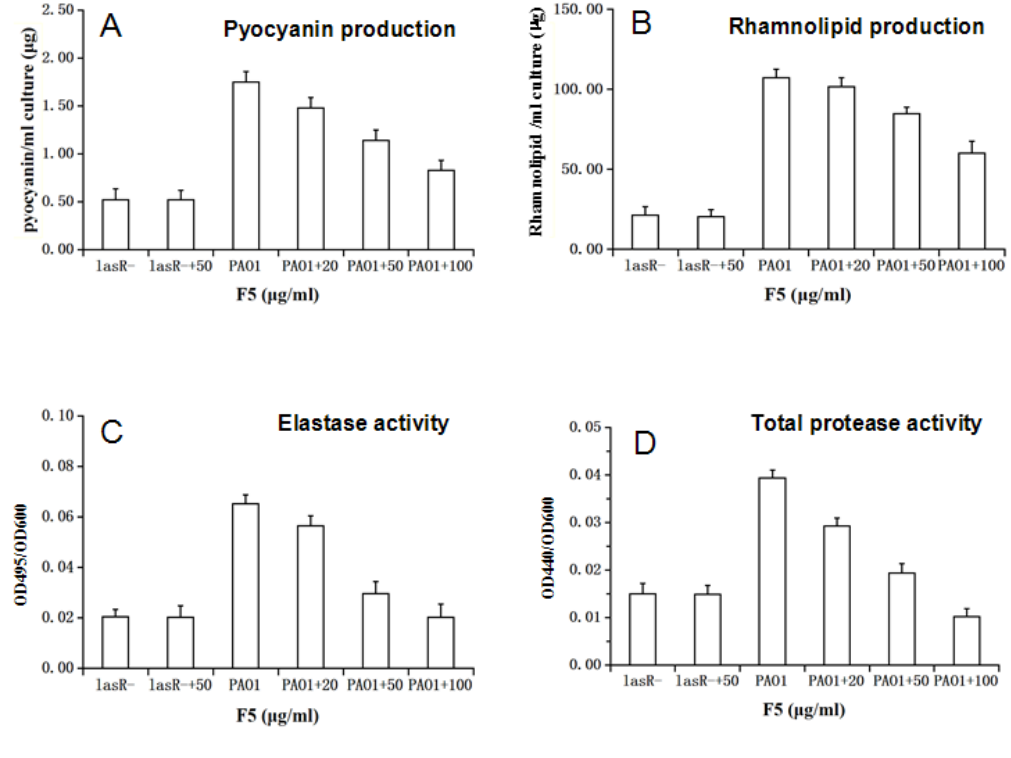
Figure 2. The effect of partially pure inhibitor F5 on the virulence factors in PAO1 and lasR − mutant. Effect of serial dilutions of the final extract on pyocyanin production ( A ); rhamnolipid production ( B ); elastase activity ( C ); and protease activity ( D ) in